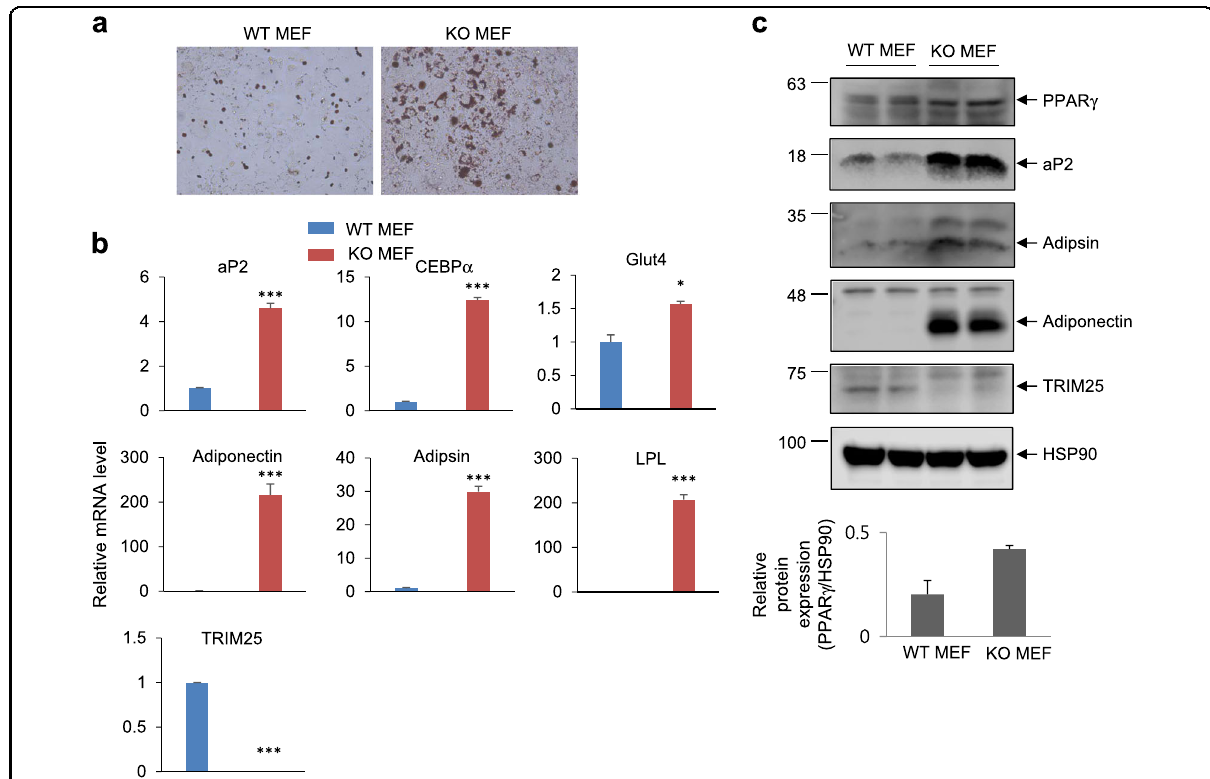
Fig. 7 Elimination of TRIM25 induces adipogenesis in mouse embryonic fi broblast (MEF) cells. TRIM25-knockout MEFs were induced for adipocyte differentiation. a Differentiated cells were stained with Oil Red O. b The mRNA expression of adipogenic markers was analyzed by real-time quantitative PCR. c The protein expression of TRIM25, PPAR γ , and adipogenic markers was analyzed by western blotting. Relative PPAR γ protein levels were measured using ImageJ (bottom graphs). All error bars shown are the s.e.m. (* p < 0.05, *** p <